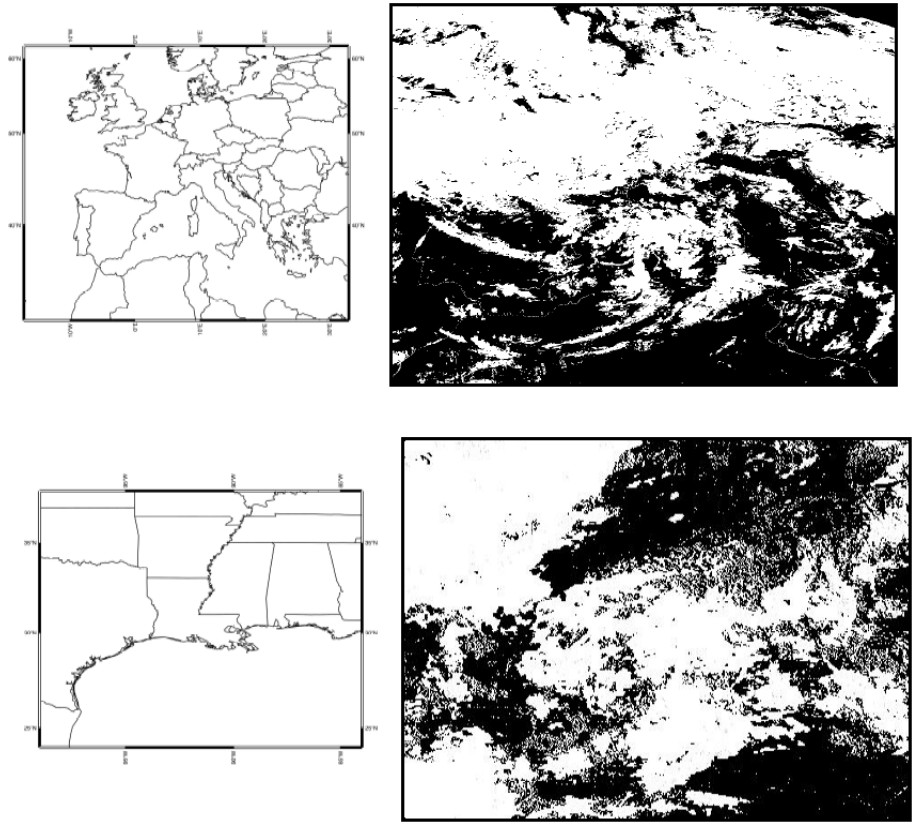
Fig. 2. Example of the cloud classification by: (a) the CM-SAF algorithm and (b) the GOES-10 algorithm. Black pixels are classified as cloud-free and white as clouds.